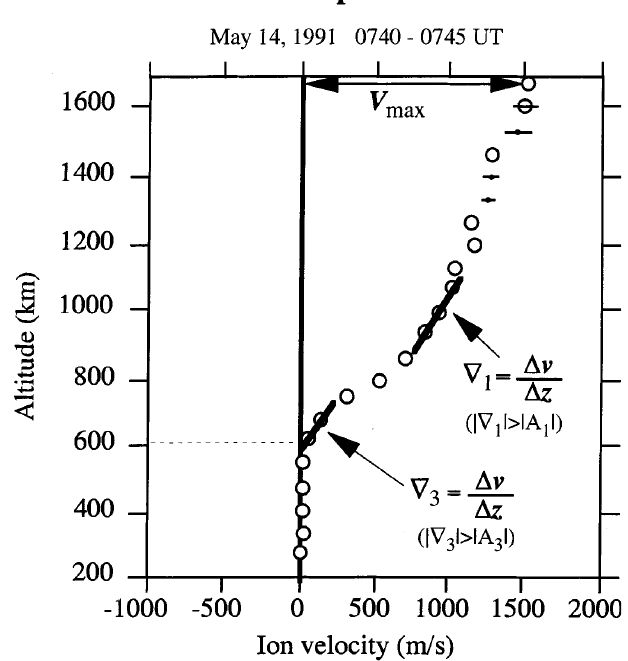
Fig. 3. The quantitative definition used in this study for selecting the ion upflow and downflow events from the CP 7 database. See text for the details